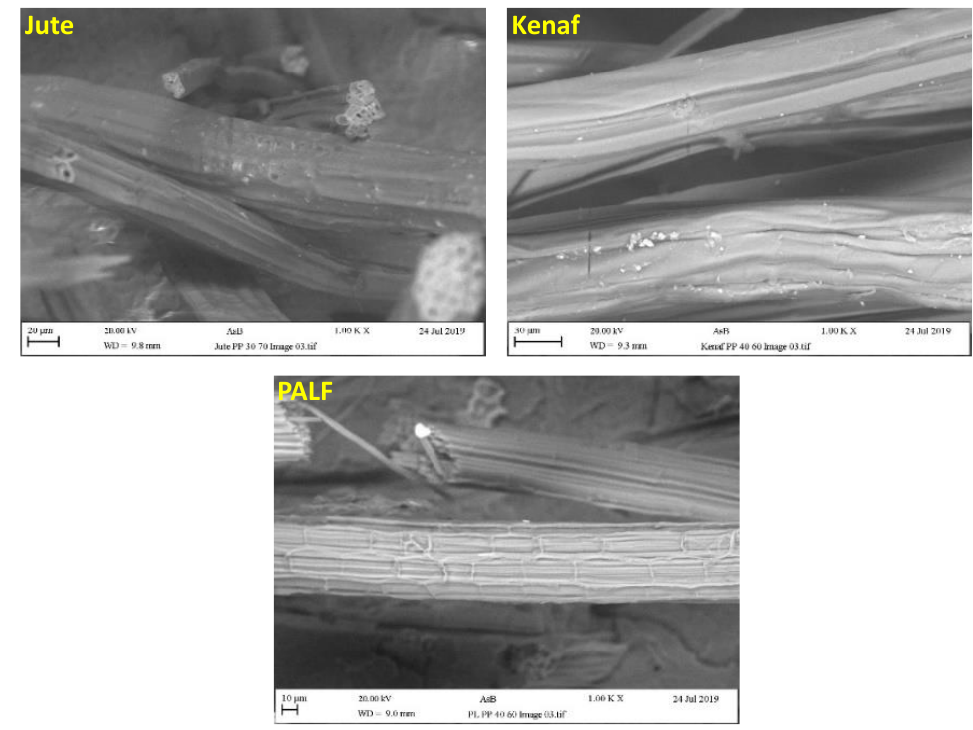
Figure 1. Surface morphologies of jute, kenaf, and PALF fibers.